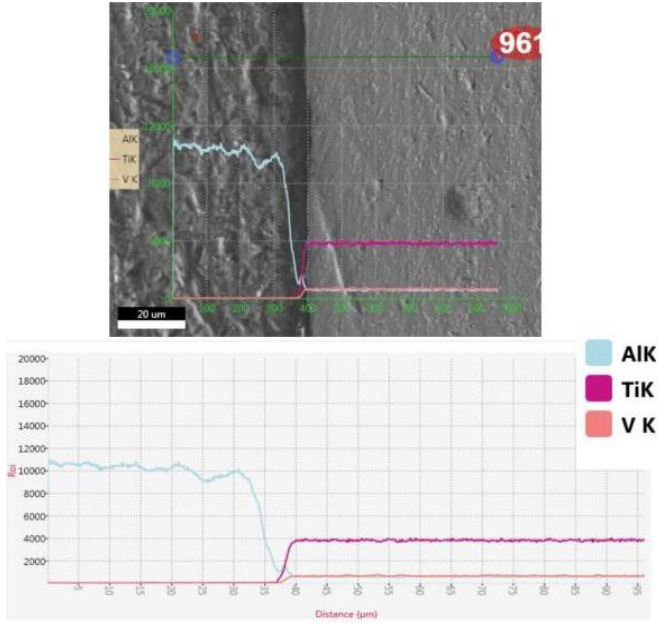
Figure 9. Linear EDS direction and line scanning result: element profile plot of Sample A3.